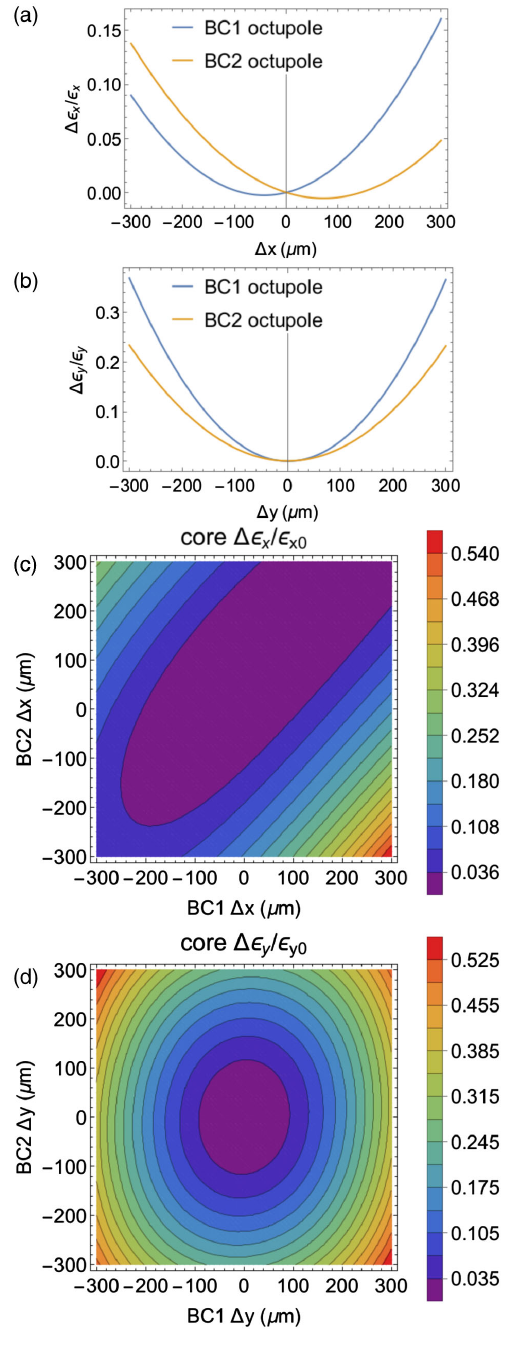
FIG. 9. (a) The proportional increase in the x emittance in the core of the beam at the exit of BC2, with varying BC1 octupole x-offset (blue) and BC2 octupole x-offset (yellow) (b) The proportional increase in the y emittance in the core of the beam at the exit of BC2, with varying BC1 octupole y-offset (blue) and BC2 octupole y-offset (yellow). (c) The proportional increase in the x emittance in the core of the beam at the exit of BC2, with varying both BC1 and BC2 x-offset. (d) The proportional increase in the x emittance in the core of the beam at the exit of BC2, with varying both BC1 and BC2